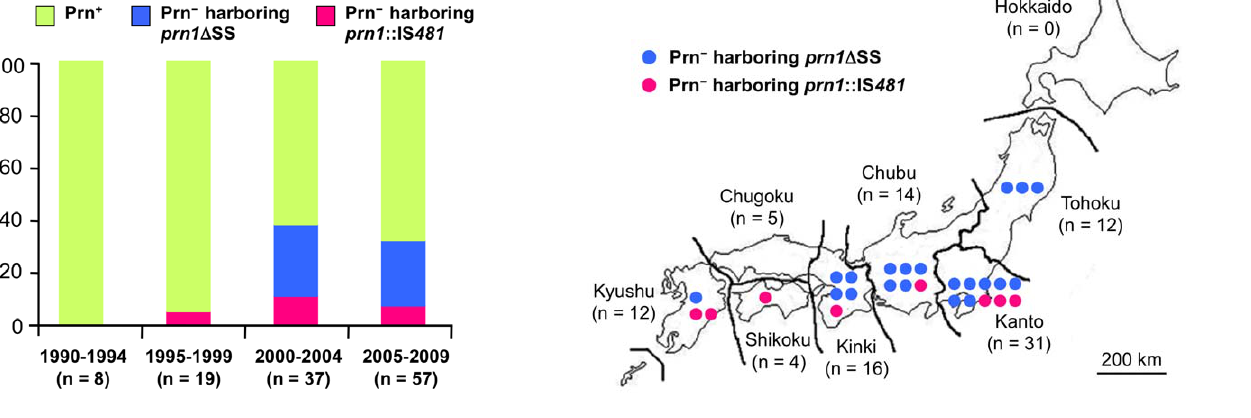
Figure 4. Geographical distribution of Prn 2 isolates in Japan during 2001–2009. Blue and red circles indicate Prn 2 isolates harboring prn1 D SS and prn1 ::IS 481 , respectively. Numbers of isolates tested are indicated in parentheses.